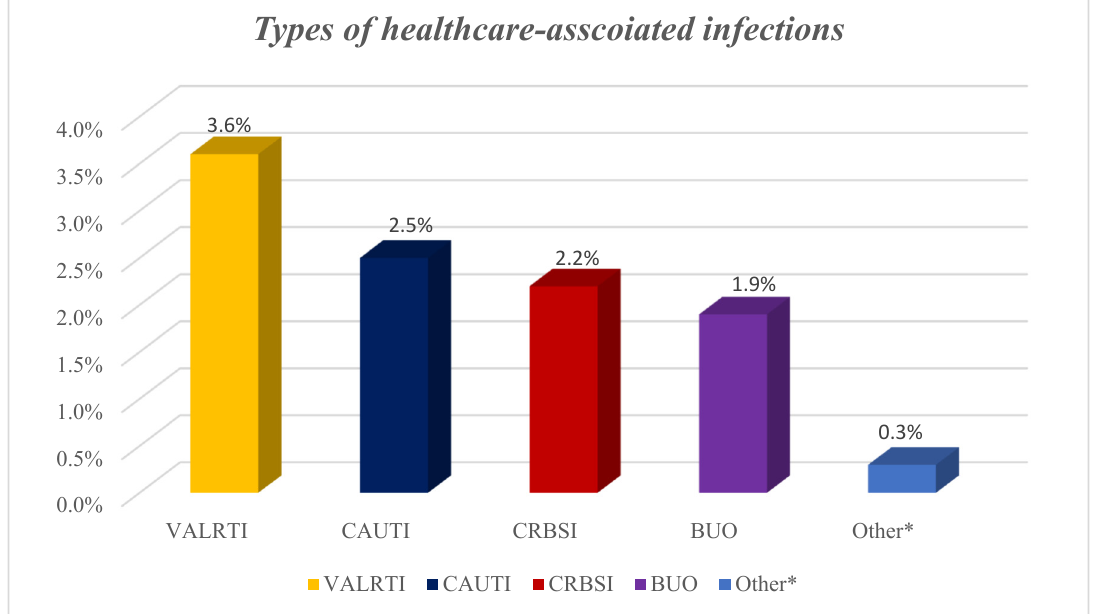
Figure 2. Types of healthcare-associated infections among COVID-19 patients. NB: BUO: bloodstream infections of unknown origin; CAUTI: catheter-associated urinary tract infection; CRBSI: catheter- related blood stream infection; HAI: healthcare-associated infections; VALRTI: ventilator-associated lower respiratory tract infections; Others* included fungal